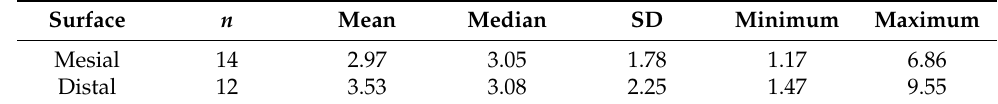
Table 1. Descriptive analysis of the area (mm 2 ) of the enamel removed after the interproximal enamel reduction procedure at the mesial and distal interproximal enamel surfaces of the STL digital files.